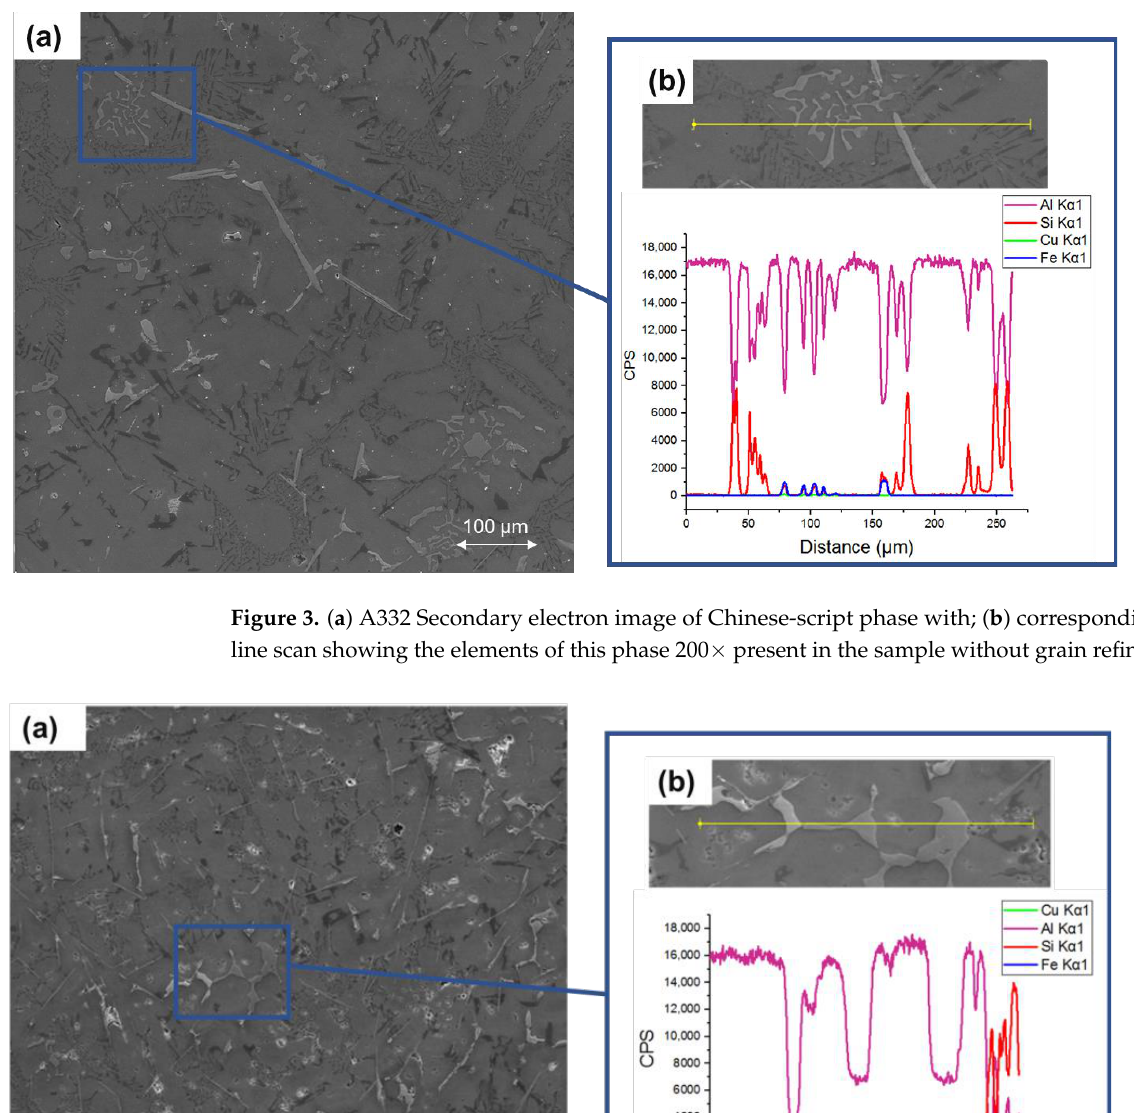
Figure 4. ( a ) Secondary electron image A332 with Al5Ti1B; ( b ) corresponding EDS line scan showing the elements peaks of Al 2 Cu phase 200×.